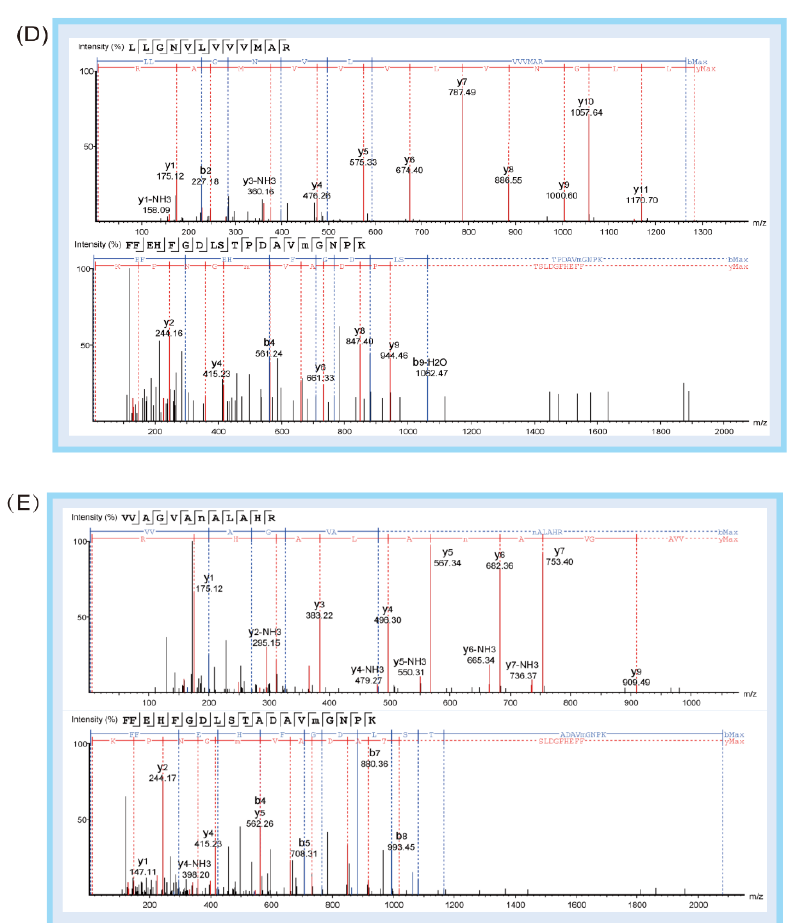
Figure 2. Corresponding sequence analysis maps (b-blue, y-red) of 11 peptide biomarkers relevant to the identification strategy 1. ( A ) This graph shows three Eurasian elk-specific peptide biomarkers: Peptide 1 (EFTPELQADYQK), Peptide 2 (VDEVGGEALGR), and Peptide 3 (FFEHFGDLSTADAVMHNAK). ( B ) This graph shows three reindeer-specific peptide biomarkers: Peptide 4 (VDEVGAEALGR), Peptide 5 (MLTSEEK), and Peptide 6 (DFTPVLQADFQK). ( C ) This graph shows one white-tailed deer-specific peptide biomarker: Peptide 7 (FFEHFGDLSSADAVMGNPK). ( D ) This graph shows two white-lipped deer-specific peptide biomarkers: Peptide 8 (LLGNVLVVVMAR) and Peptide 9 (FFEHFGDLSTPDAVMGNPK). ( E ) This graph shows two sika deer-specific peptide biomarkers: Peptide 10 (VVAGVANALAHR) and Peptide 11 (FFEHFGDLSTADAVMGNPK).